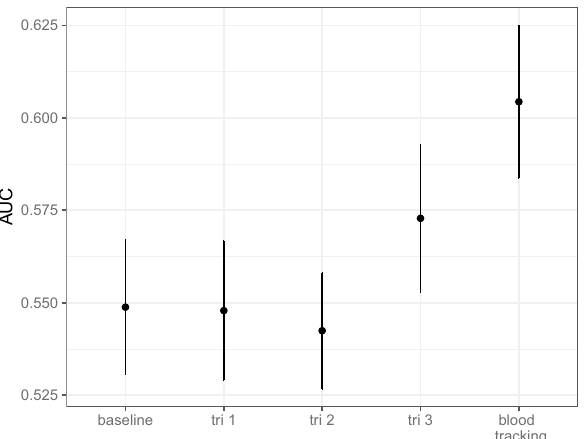
Figure 3. Comparison of model predictive performance. Mean and SE of the area under the receiver operator curve (AUC) for repeatedly held out samples of 200 independent patients from a model including only age and ancestry (baseline), baseline and complete blood count (CBC) measures taken at trimester 1 (tri 1), baseline and complete blood count (CBC) measures taken at trimester 2 (tri 2), baseline and complete blood count (CBC) measures taken at trimester 3 (tri 3), and baseline and complete blood count (CBC) measures taken across pregnancy (blood